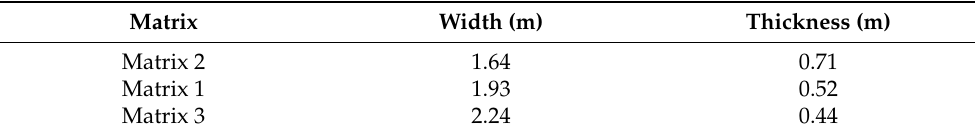
Figure 16. Effect of changing only the angle of the ore in the matrix on the shape of the ore-free zone. Table 12. Width and thickness of the ore-free zone when changing only the angle of the ore in the matrix.